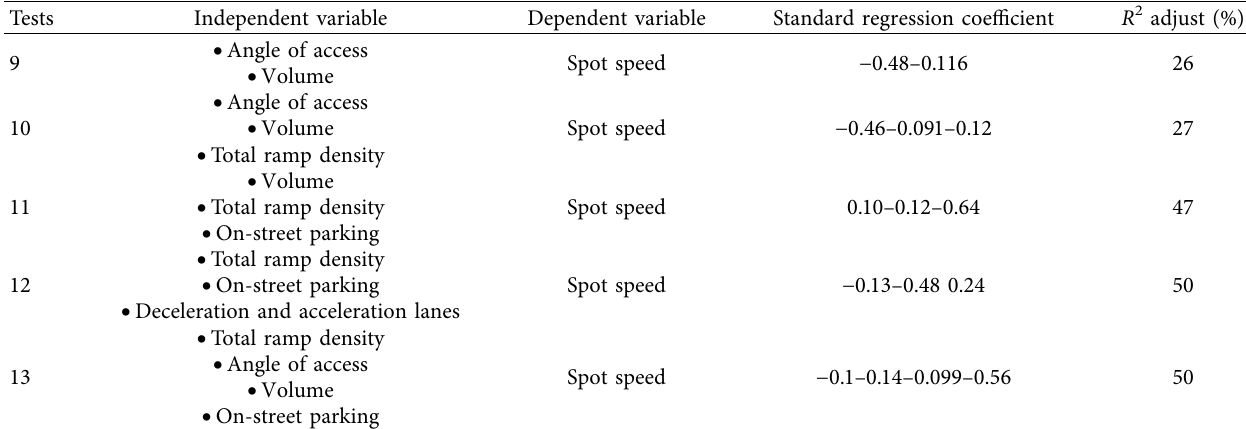
Table 3: Linear regression model, the simultaneous effect of two or more independent variables on the dependent